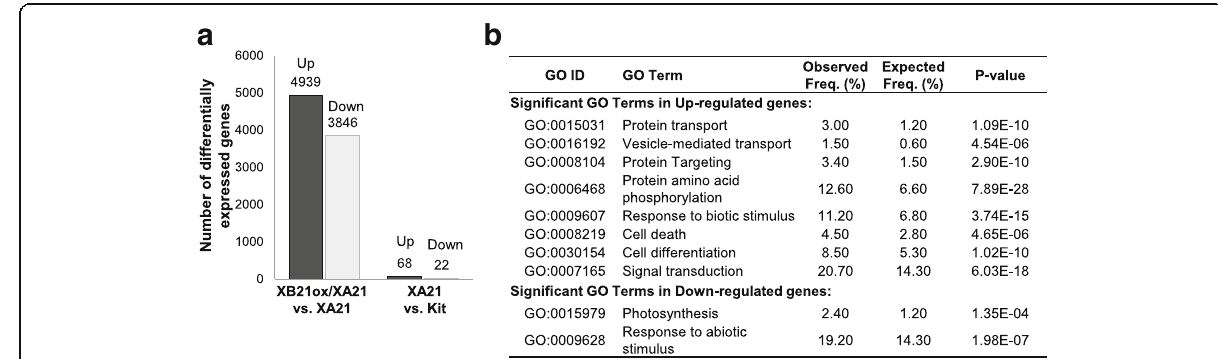
Fig. 7 Transcriptional dynamics in response to overexpression of XB21 in transgenic rice plants carrying XA21 . a Results of differential expression analysis. Numbers of up- and down-regulated genes ( ≥ 2-fold change, FDR ≤ 0.01) in XA21 plants overexpressing XB21 vs. XA21 plants (XB21ox/ XA21 vs. XA21) and XA21 plants vs. Kitaake wild type (XA21 vs. Kit) are presented. b Gene Ontology (GO) enrichment analysis for differentially expressed genes ( ≥ 2-fold with FDR ≤ 0.01) performed using Virtual Plant database. Only the top ranked GO terms for “ biological process ” category are listed. The FDR, calculated using hypergeometric distribution analysis, are (Additional file 2: Table S1 and Additional file 3: Table S2).